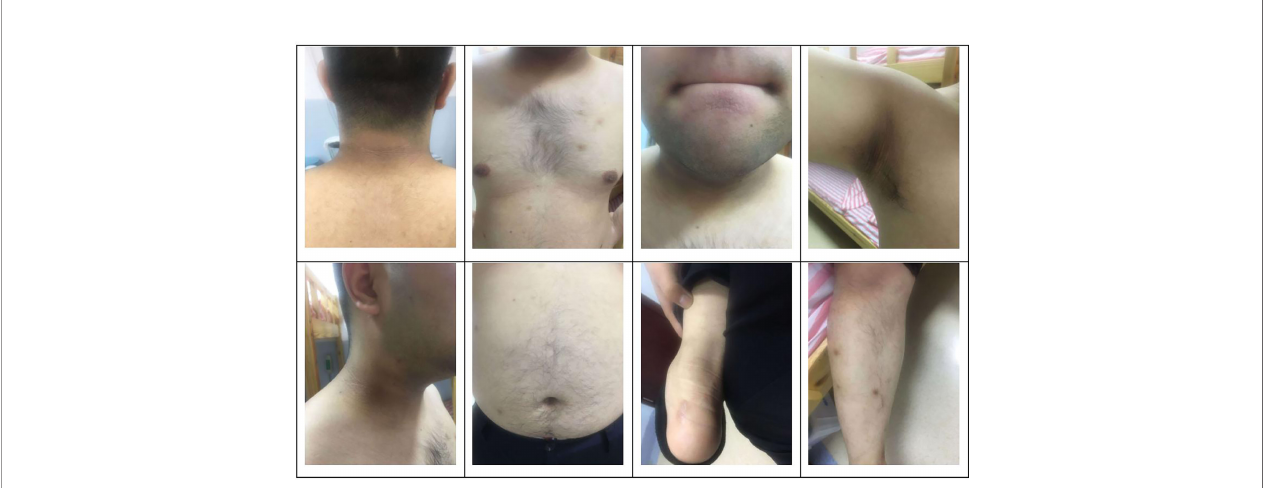
FIGURE 1 | Clinical characteristics of the patient: obvious pigmentation in the skin around the neck, underarm pit and inguinal areas and rough hyperplasia with increasing hair in the chest and